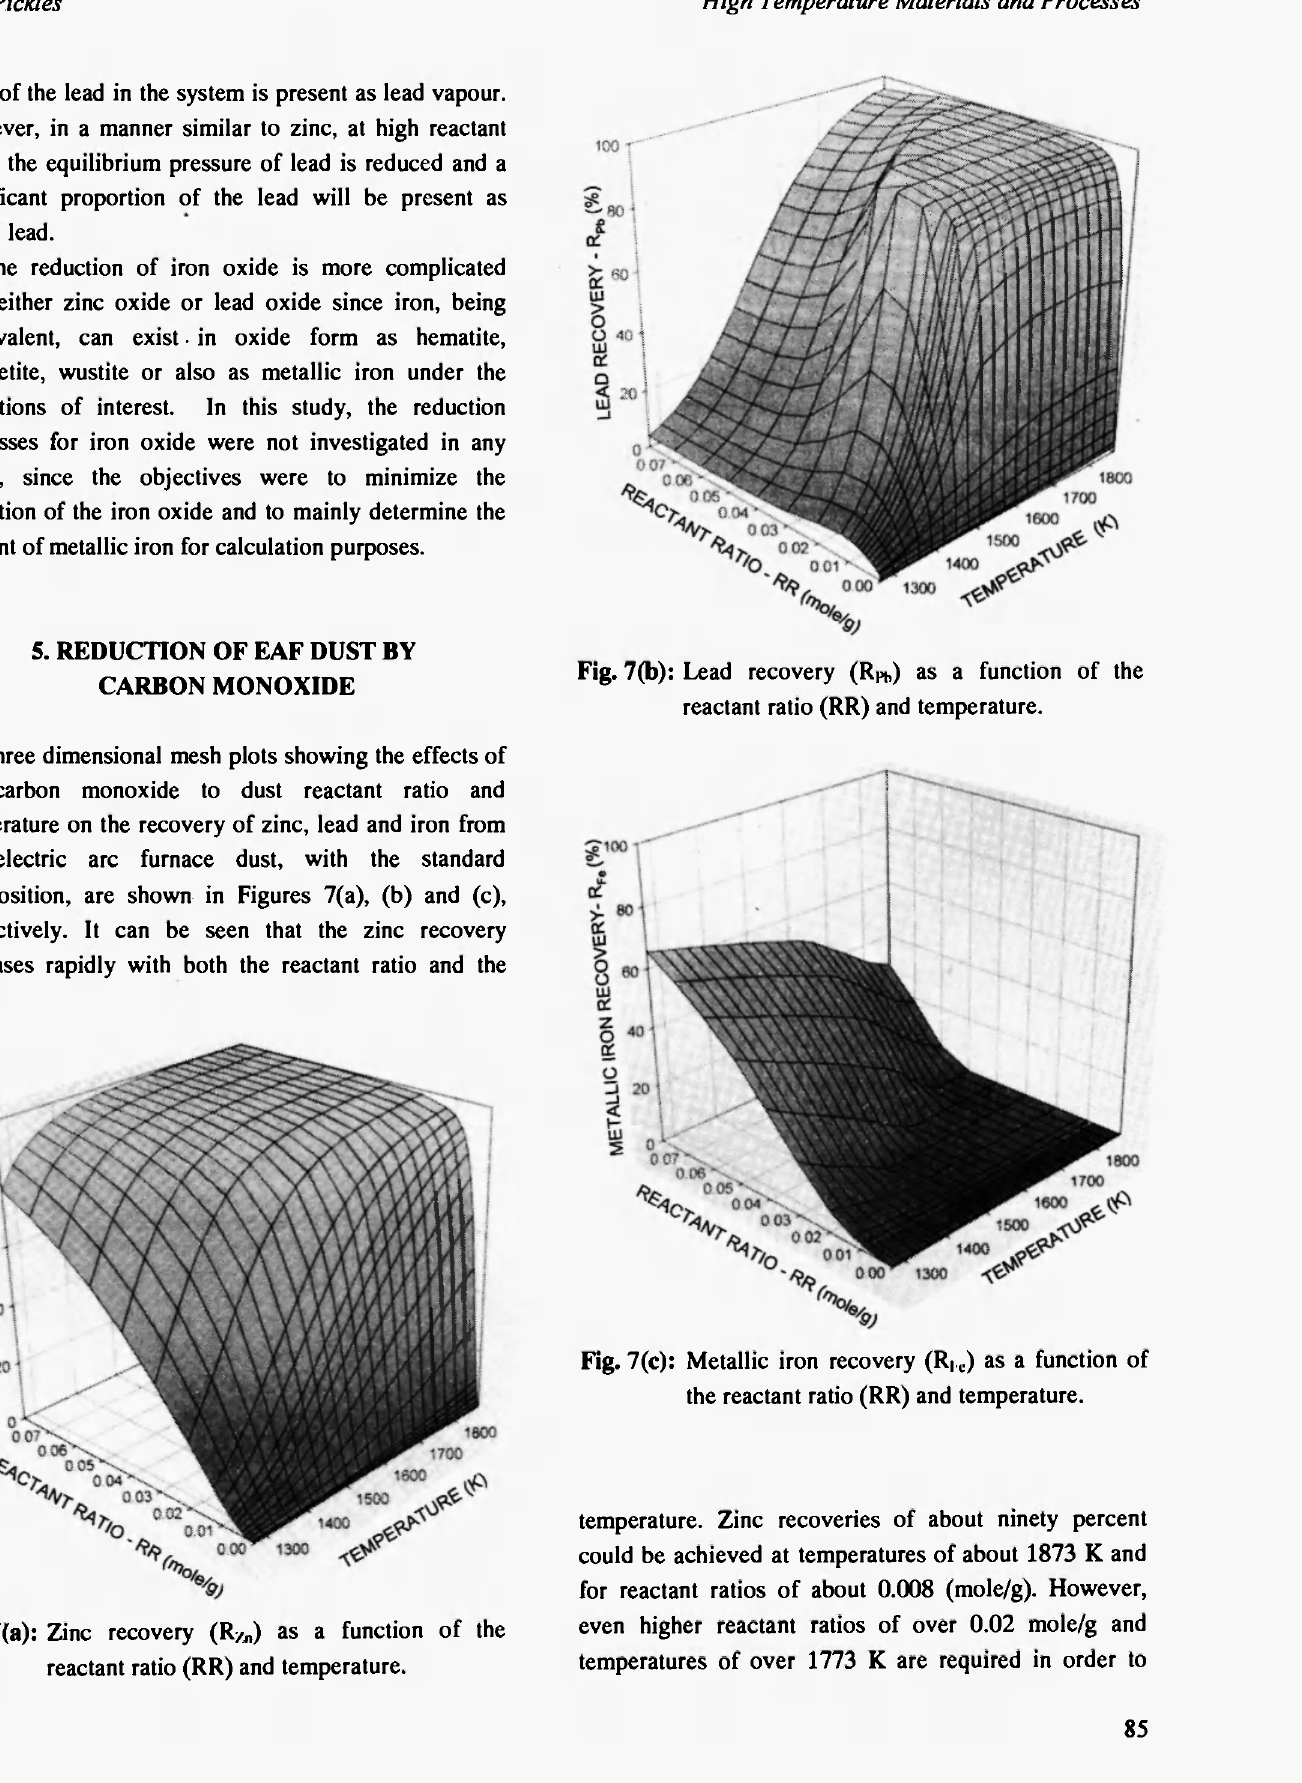
Fig. 7(a): Zinc recovery (R /n ) as a function of the reactant ratio (RR) and temperature.